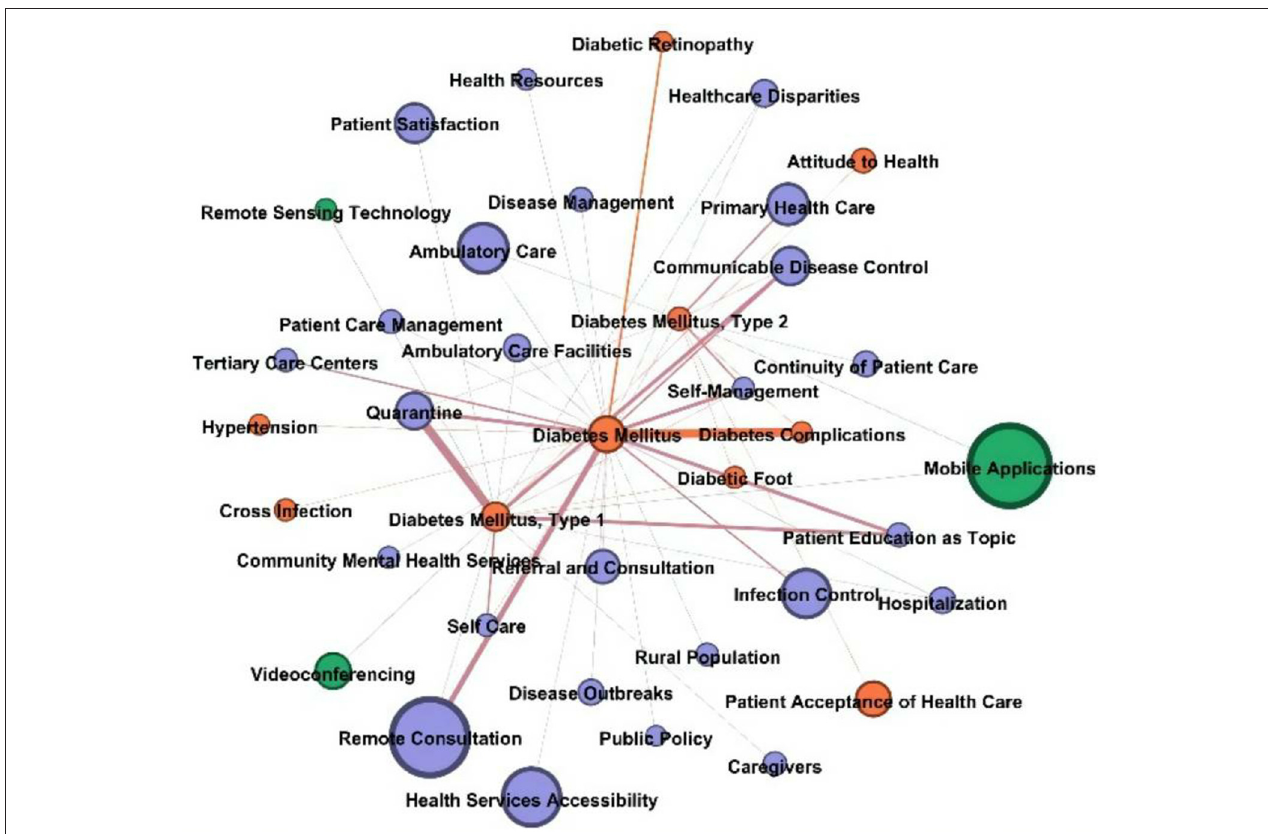
FIGURE 8 | Diabetes mellitus node and other nodes connections in the